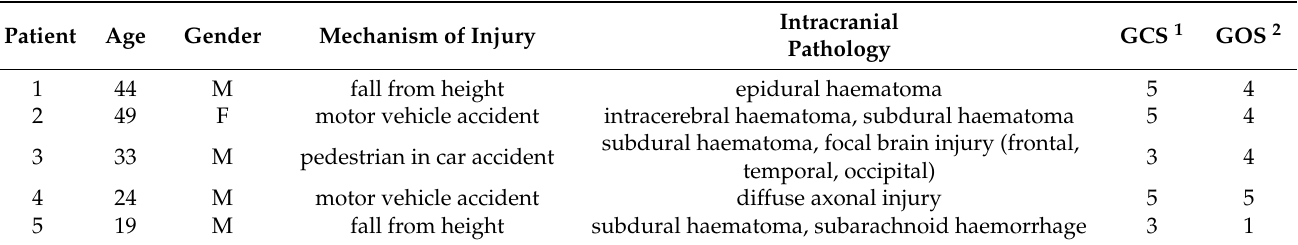
Table 1. Demographics, injury and recovery of severe traumatic brain injury (sTBI) patients included in the